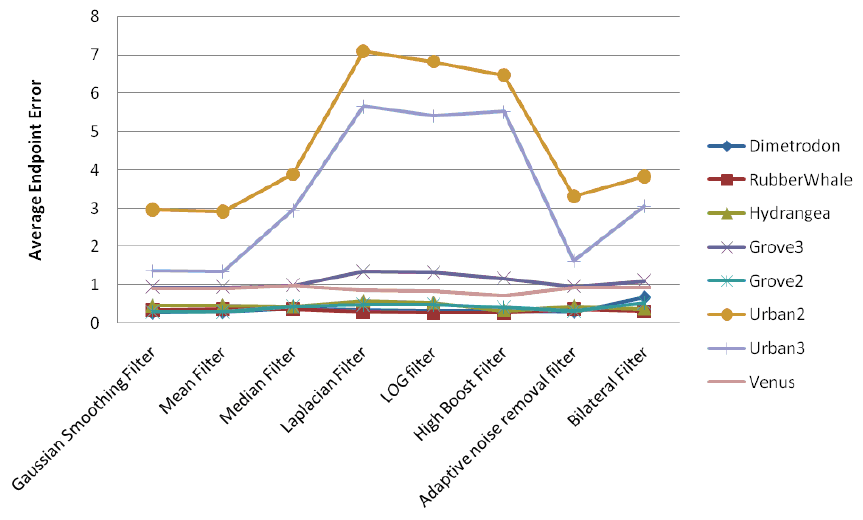
Figure 8. Average endpoint errors obtained using different filters on all resized